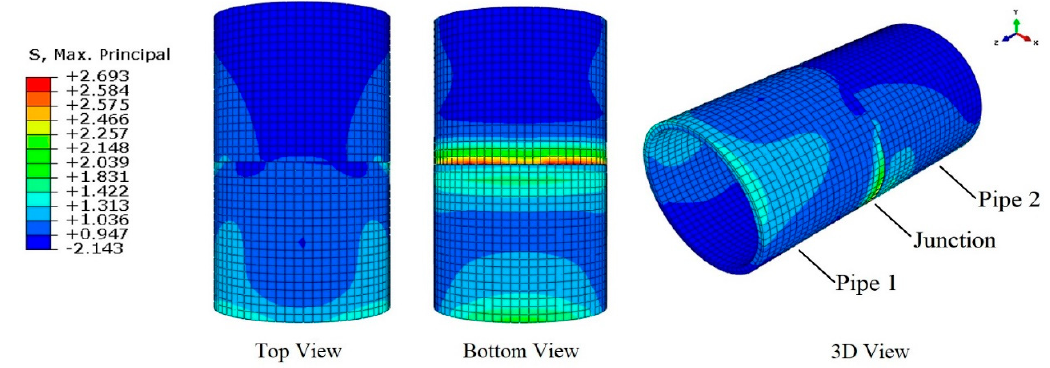
Figure 10. Stresses in the pipe wall under no-flow conditions (MPa).